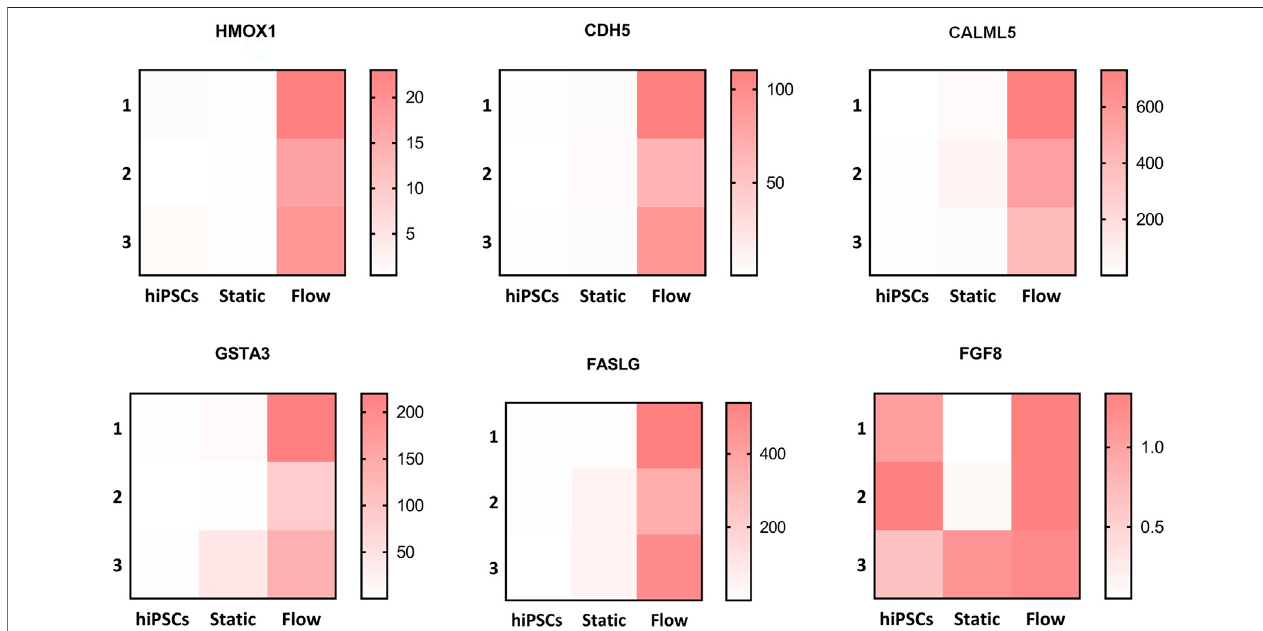
FIGURE 7 | Altered genes involved in different pathways were validated via qRT-PCR. Validation of the relative mRNA expression of HMOX1, CDH5, CALML5, GSTA3, FASLG, and FGF8 involved in pathways such as the fl uidic stress pathway, MAPK signaling pathway, Ca 2+ signaling pathway, and tight junction. The altered genes were displayed in the form of a heatmap using GraphPad